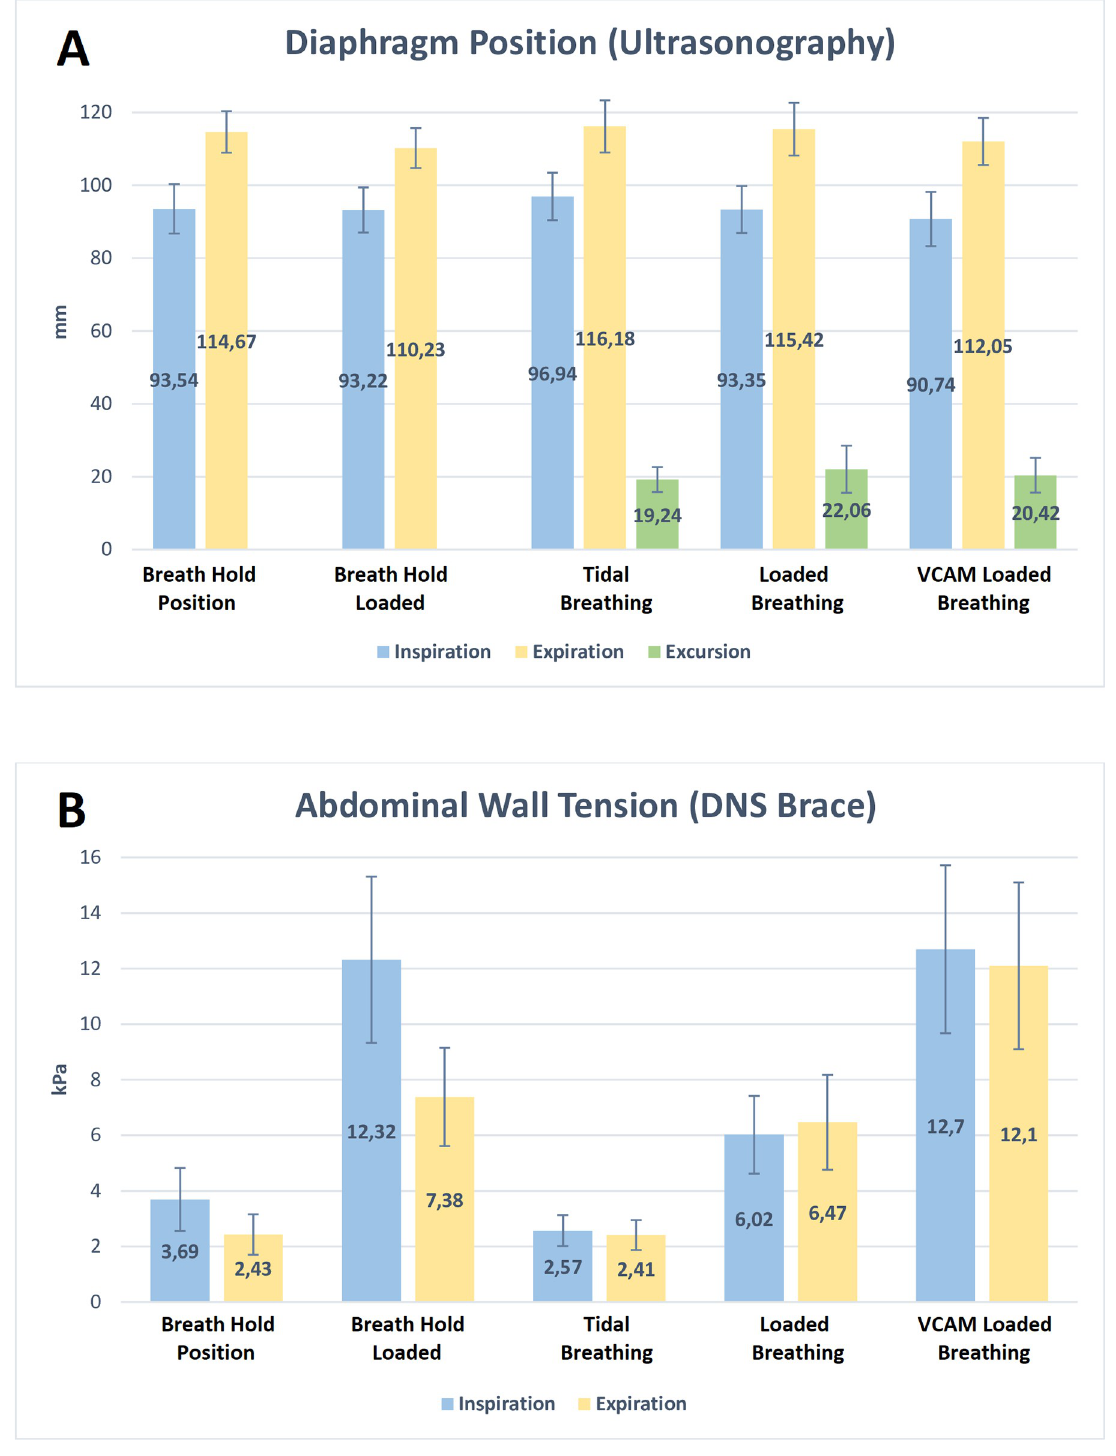
Fig 2. Graph showing outcomes of each scenario. ( A ) Diaphragm position, excursions (mm), and ( B ) abdominal wall tension (kPa) during breath-holding, tidal breathing, loaded breathing, and loaded breathing with VCAM (Mean ± Standard Deviation).